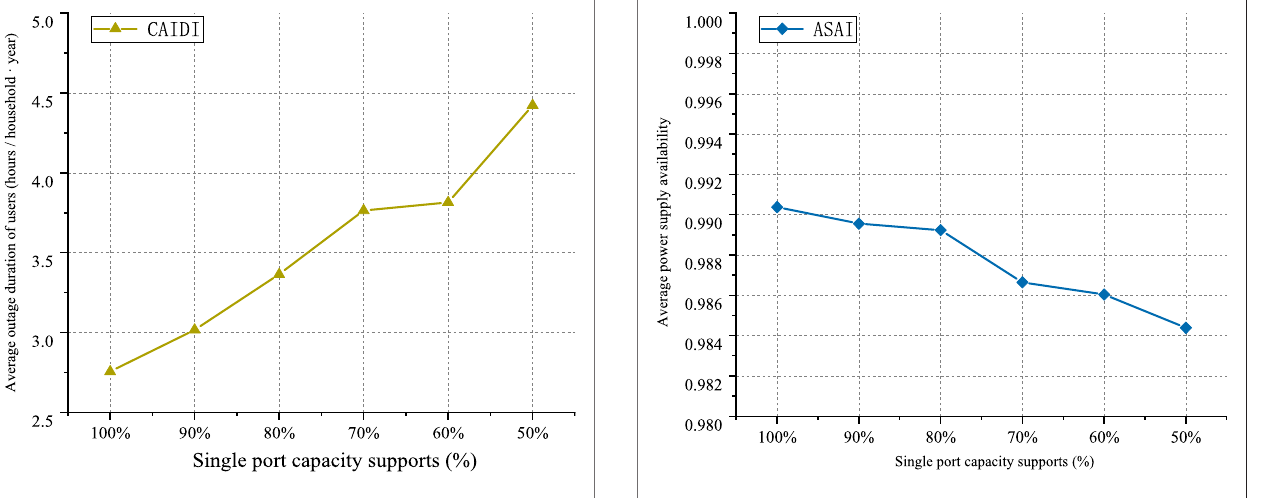
FIGURE 18 | Analysis and comparison of the impact of PET port capacity on CAIDI.